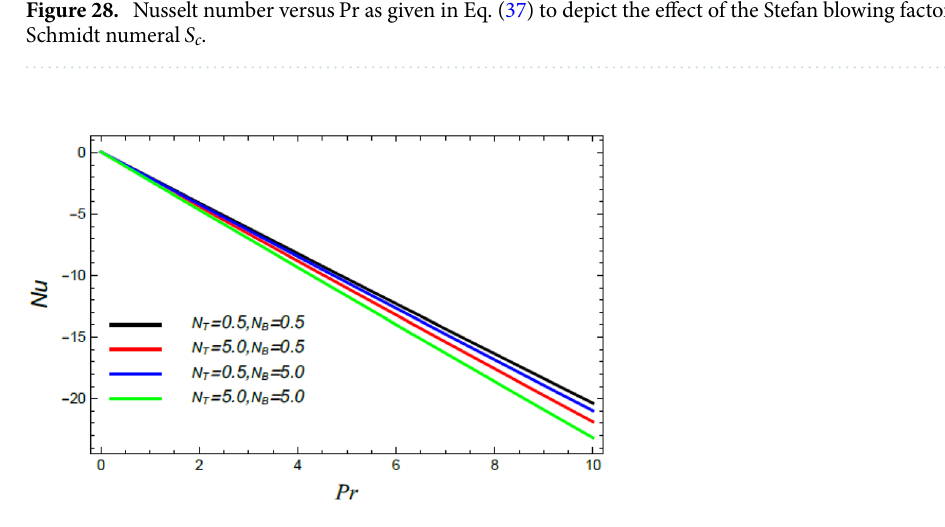
Figure 29. Nusselt number versus Pr as given in Eq. (37) to depict the impact of the Brownian motion factor N B and the thermophoresis factor N T